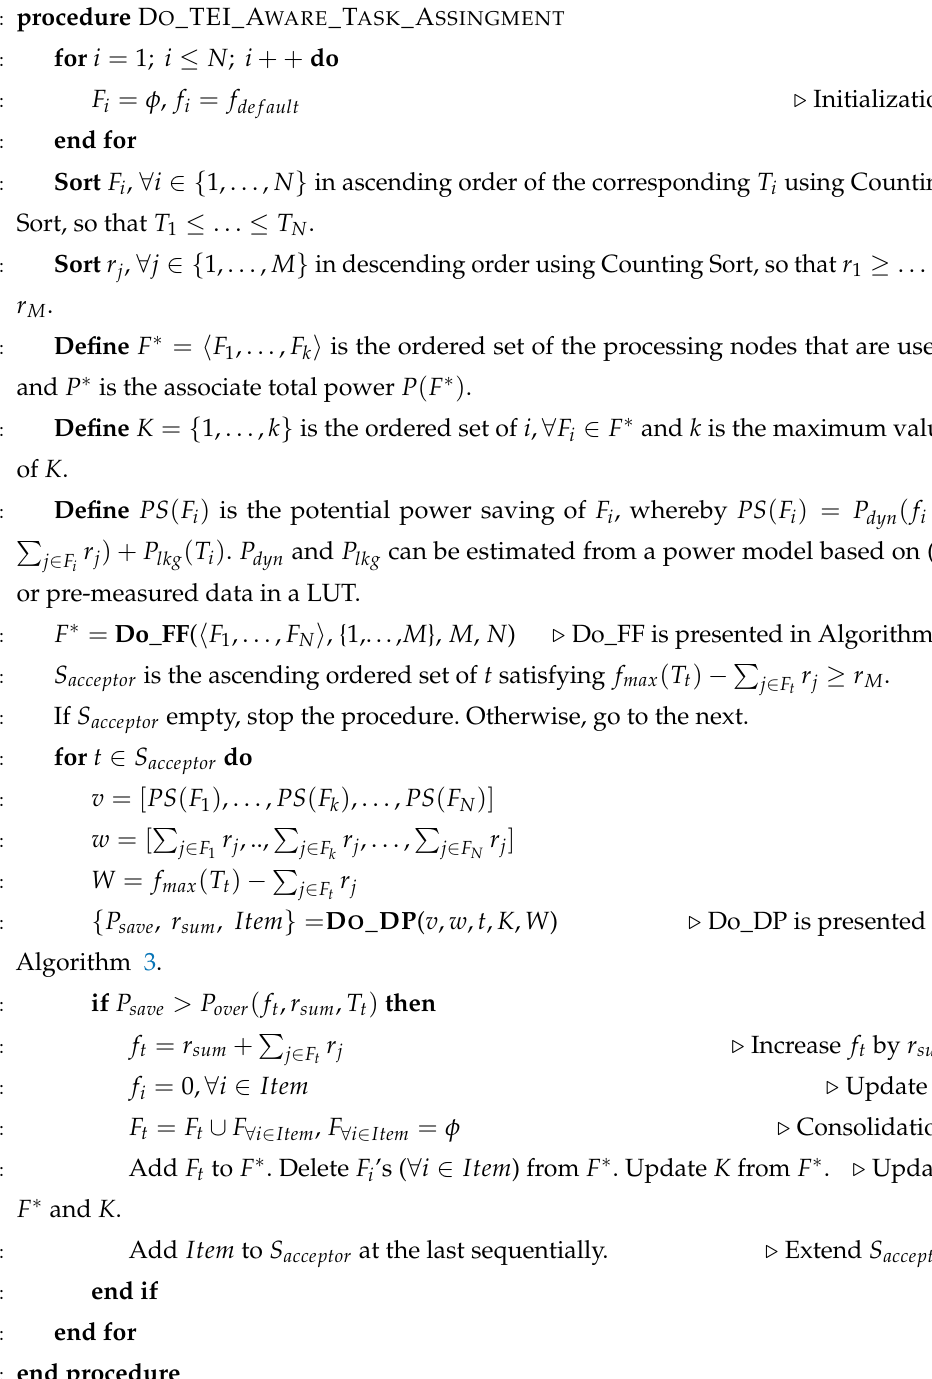
Algorithm 1 TEI-aware dynamic task assignment